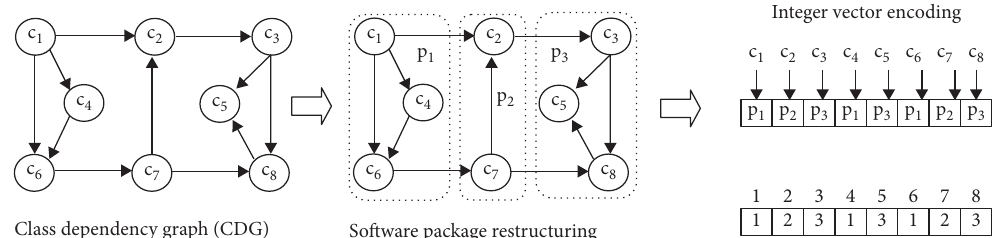
Figure 1: Integer vector-based encoding of SPR problem.